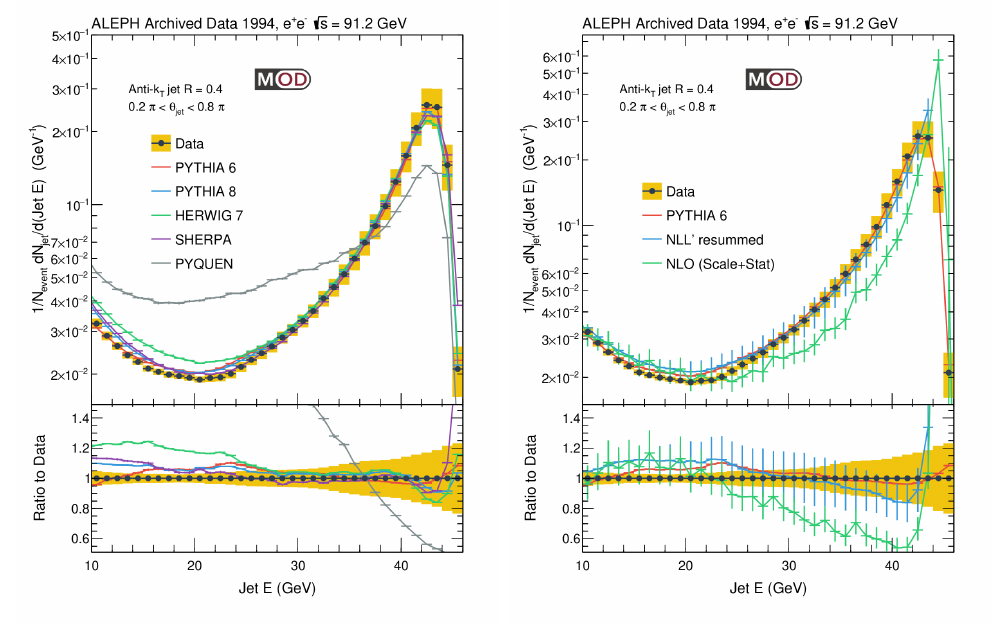
Figure 12 . Measured inclusive jet E spectrum. The spectrum is normalized by the number of events used to perform the measurement. Any overflow contribution is included in the final bin. (Left Panel) The data is compared with predictions from Pythia 6 (red), Pythia 8 (blue), Herwig (green), and Sherpa (purple) generators. The predictions are normalized to have the same area as the data. (Right Panel) The data spectra are compared with pQCD calculations at NLO and NLL’+R resummation